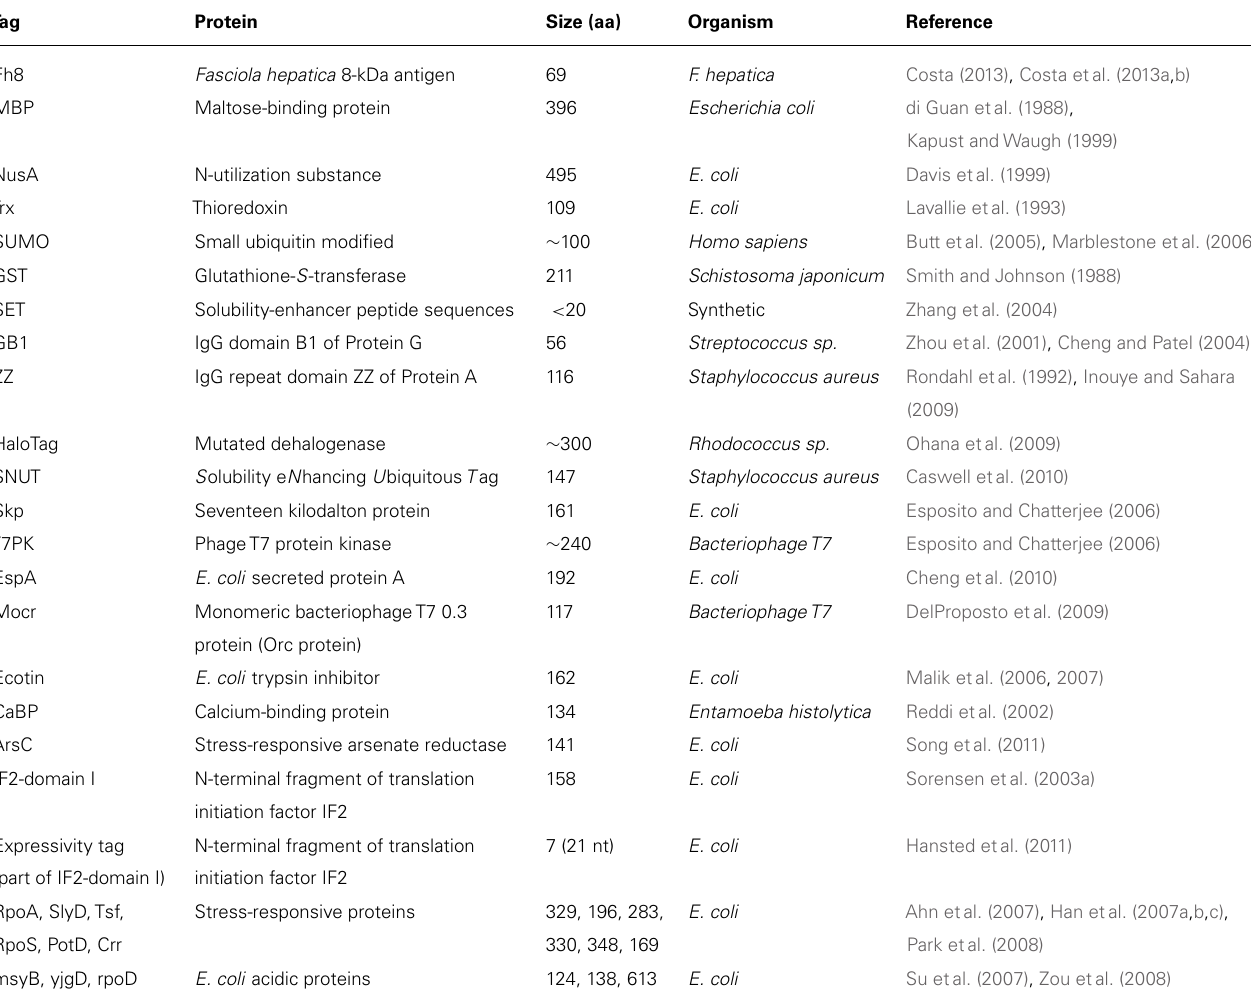
Table 1 | Solubility enhancer tags [adapted from Esposito and Chatterjee (2006), Malhotra